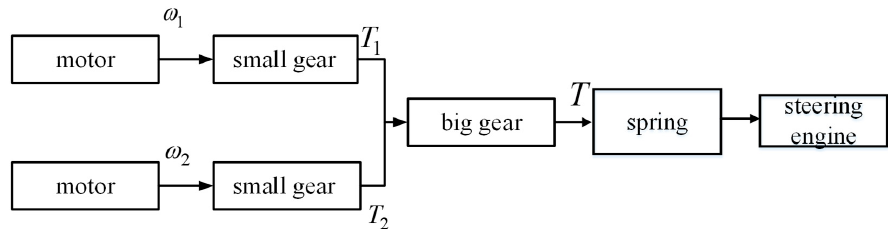
Figure 3. Dual-motor drive structure.